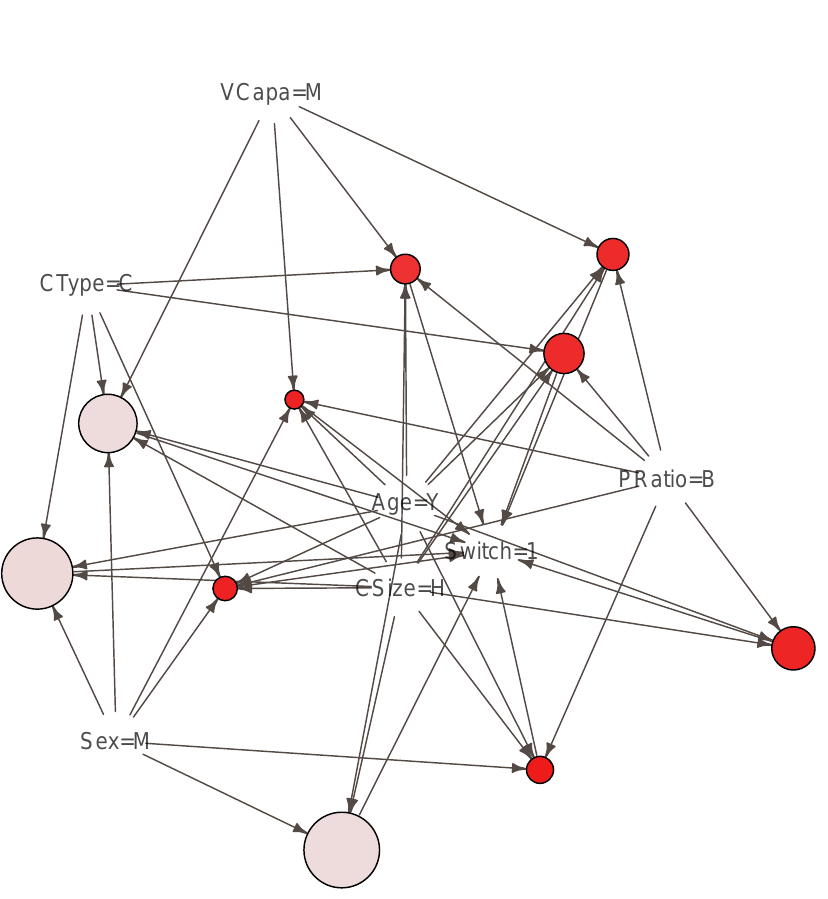
Figure 9. Graph of association rules for policy